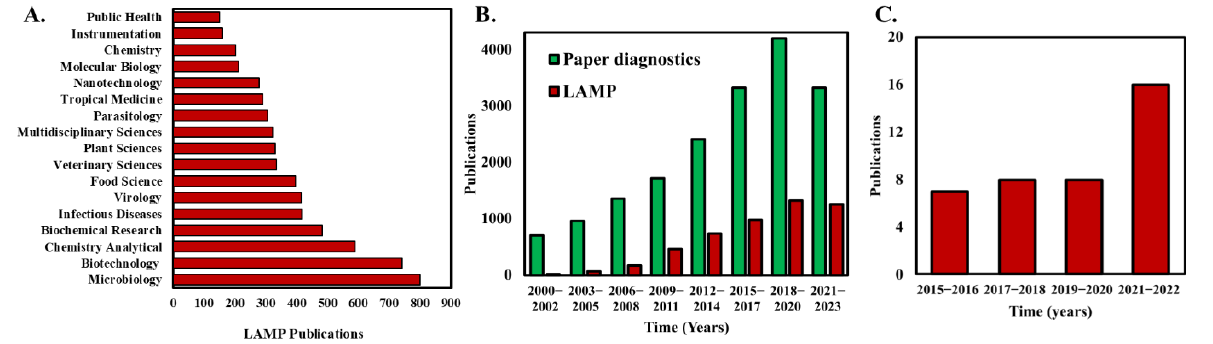
Figure 1. ( A ) Analysis of the number of publications that apply LAMP categorized by the topic area. ( B ) Analysis of annual publications in peer reviewed journals with keywords “paper diagnostics” and “Loop-mediated isothermal amplification” in the title or abstract of the publication. ( C ) The number of publications that demonstrate and use paper-based LAMP assays. Publication data were compiled on 13 January 2023 from Web of Science database using the keywords “Loop-mediated isothermal amplification” in ( A ), “Loop-mediated isothermal amplification” and “Paper diagnostics” in ( B ).